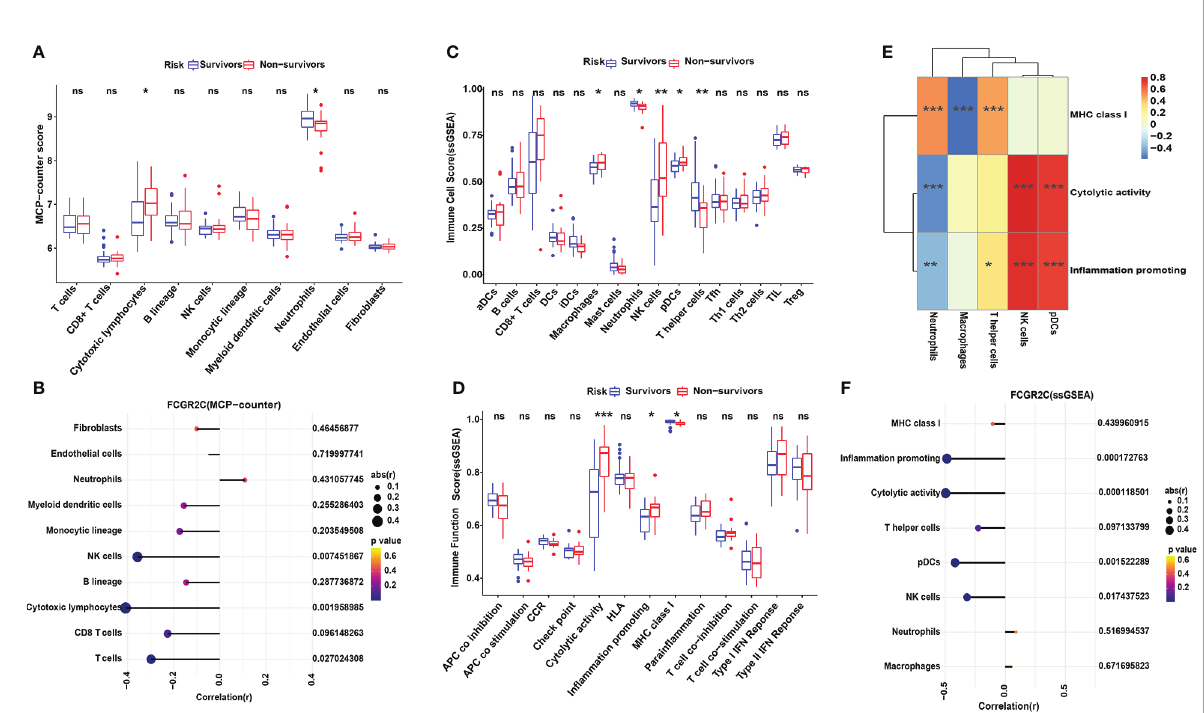
FIGURE 5 Immune cell analysis with MCP-counter and ssGSEA in the discovery cohort. (A) The MCP-counter algorithm was used to analyze the immune cell relative abundance in septic survivors and non-survivors. The MCP-counter analyzes 8 immune cell populations(T cells, CD8 T cells, cytotoxic lymphocytes, B lineage cells, NK cells, monocytic lineage cells, myeloid dendritic cells, and neutrophils) and 2 stromal cell populations (endothelial cells and fi broblasts). (B) Correlation analysis of FCGR2C with immune cells and stromal cells. ssGSEA was used to analyze the 16 immune cells (C) and 13 immune functions (D) between septic survivors and non-survivors. (E) Heatmap of the correlation between immune functions and immune cells by ssGSEA. Color changes show the correlation intensity; red indicates a positive correlation, and blue indicates a negative correlation. (F) Correlation analysis of FCGR2C with immune functions and immune cells. Dots indicate the power of the correlation, and different colors indicate the P-value. (*P< 0.05, **P< 0.01, ***P < 0.001, ns:no signi fi